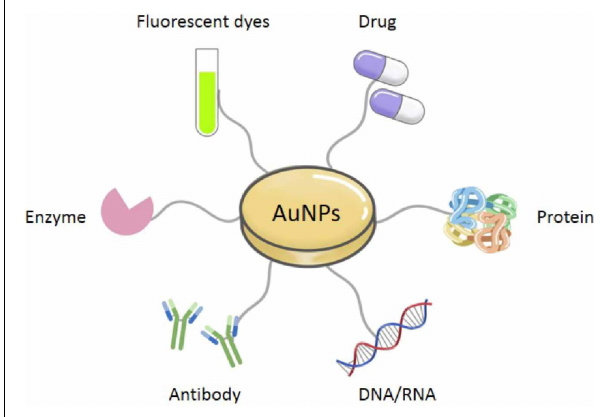
FIGURE 2 | Various connecting molecules of